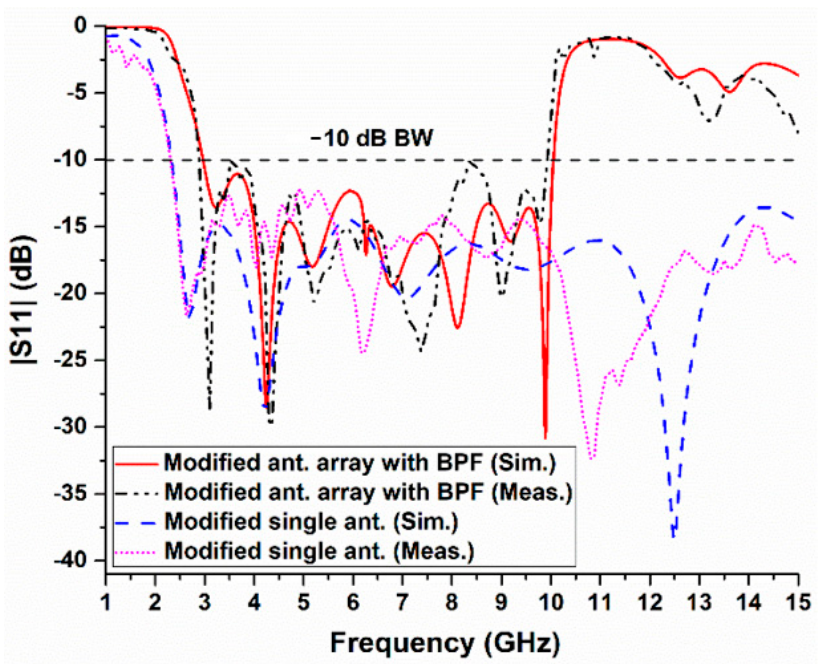
Figure 15. Simulated and measured reflection coefficients of a single modified UWB antenna and UWB antenna array integrated with BPF.